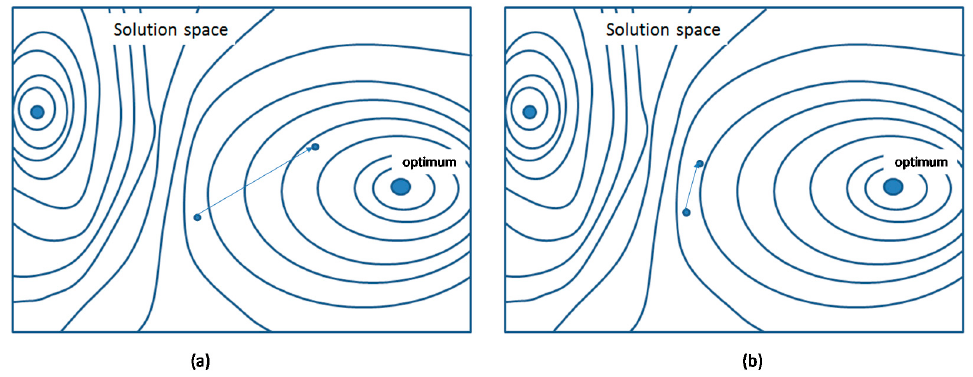
Figure 5. Comparison between the advantages of ( a ) large and ( b ) small mutations.